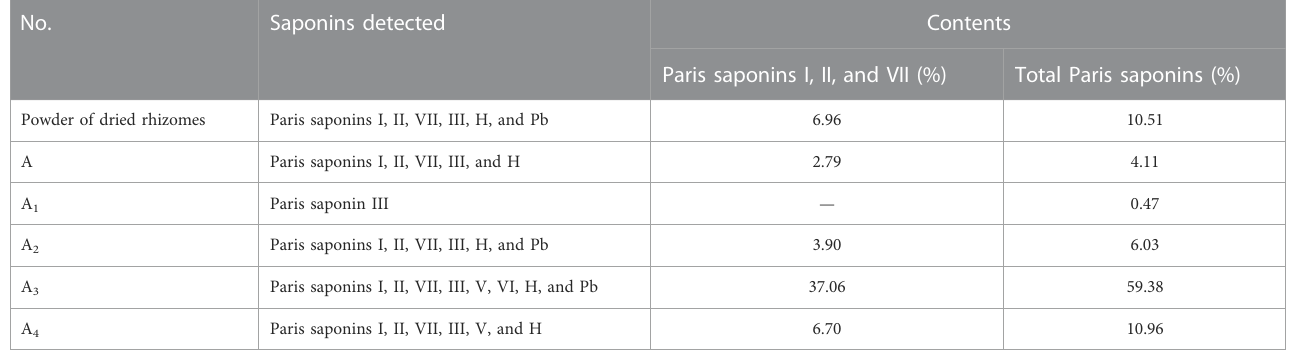
Note: — , not detected.